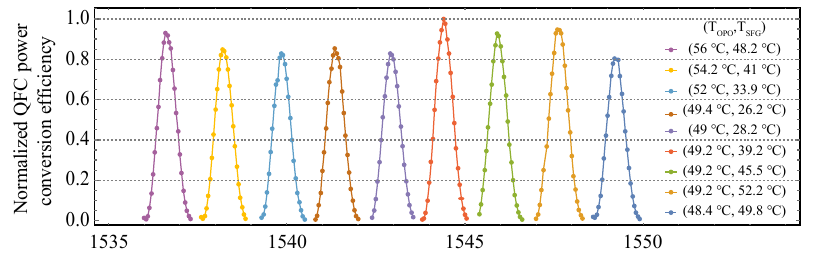
Figure 4: Normalized QFC power